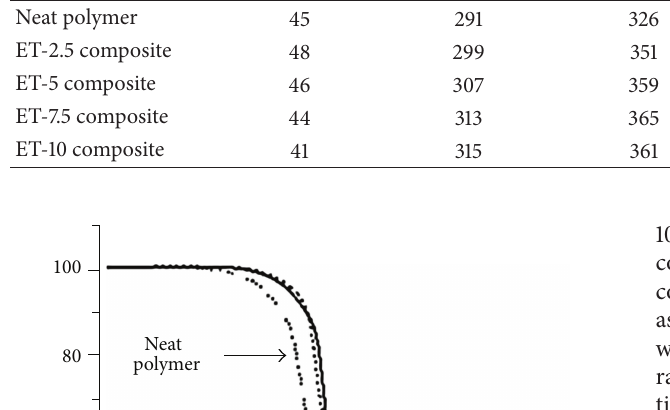
Table 1: Thermal properties of neat epoxy polymer and epoxy-titania composites with different concentrations of submicron titania particles. Sample